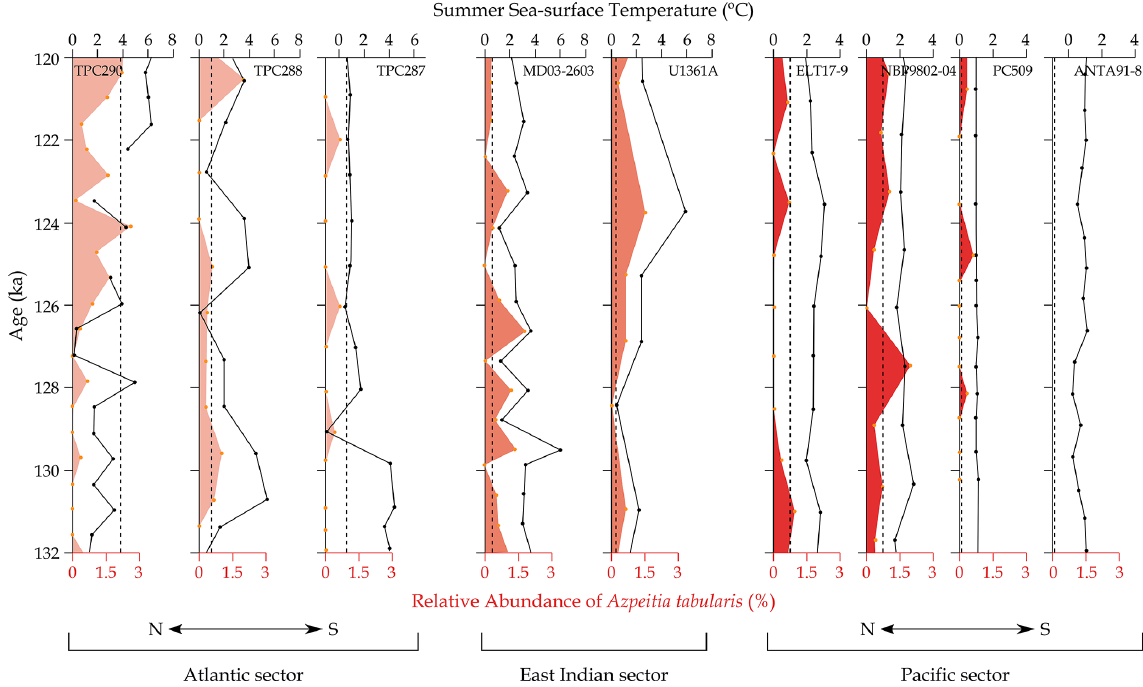
Figure 4. Down-core summer (January to March) SSTs, determined using the MAT, and the relative abundance of Azpeitia tabularis for the 132–120ka interval in nine marine sediment cores. The red shading indicates the relative abundance of A. tabularis , with the colour saturation varying between SO sectors. The solid black lines indicate the SSSTs with the gaps in the TPC290 record caused by two samples being too dissimilar from all modern reference samples so that the latter cannot be considered analogues. Black dashed lines mark the modern (January–March, 1980–2019) SSSTs at each core site (Hersbach et al., 2019). Within each SO sector cores are arranged from north to